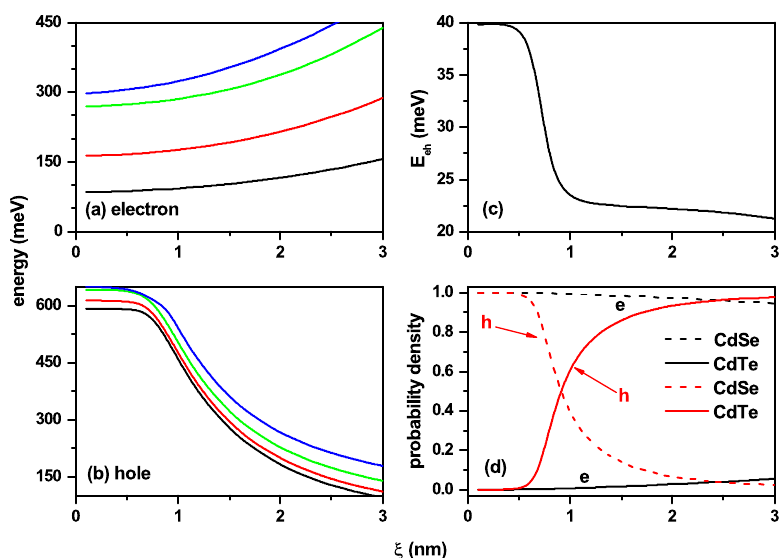
Figure 9. Characterization of the exciton effects in a truncated CdSe–CdTe conical-shaped quantum dot as a function of the ξ -parameter in accordance with Figure 8b. The lowest energy levels for the electron ( a ) and hole ( b ) are shown. In ( c ), the results are for the electron–hole Coulomb energy, whereas in ( d ), the probability density for both electron and hole in each CdSe and CdTe material are presented. The calculations are for R 1 = 3 nm, R 2 = 8 nm, h = 12 nm, B = 0, and impurity